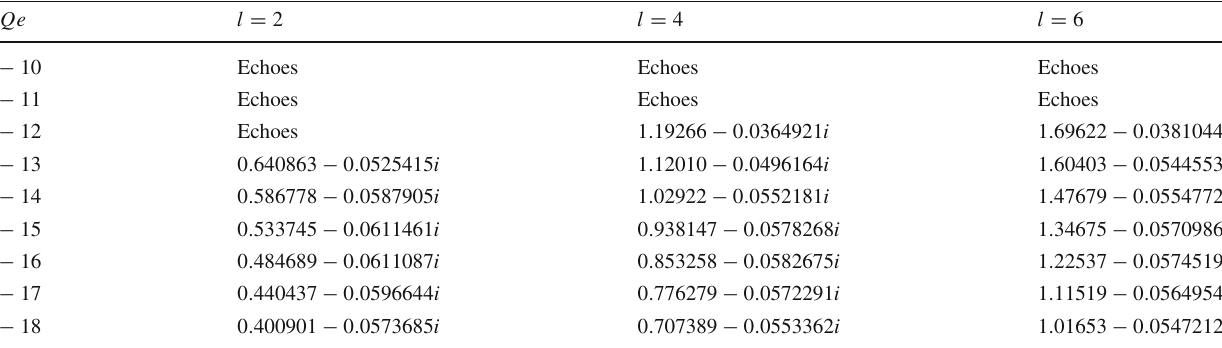
Fig. 5 The effective potentials and the corresponding time evolution profiles with different Q e . We set M = 0 . 147059 ,γ 1 = − 10 ,γ 2 = 2 , l = 2 Table 1 The QNM frequencies with different Q e . We set M = 0 . 147059 ,γ 1 = − 10 ,γ 2 = 2